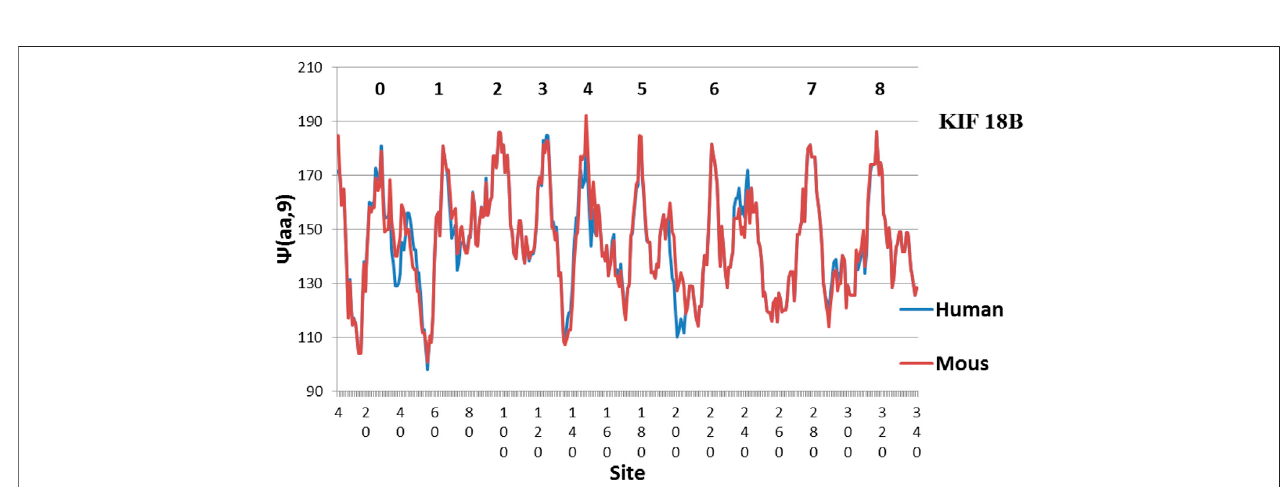
FIGURE 2 | The large differeences between Human KIF18B suggest that Chicken KIF 18B may perform a special function, as its hydrophobic extrema are much more level (MZ scale).